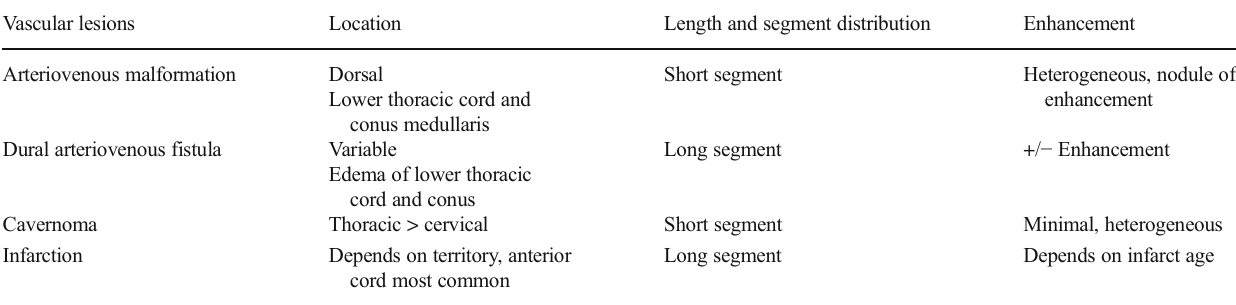
Vascular lesions summary Vascular lesions Location